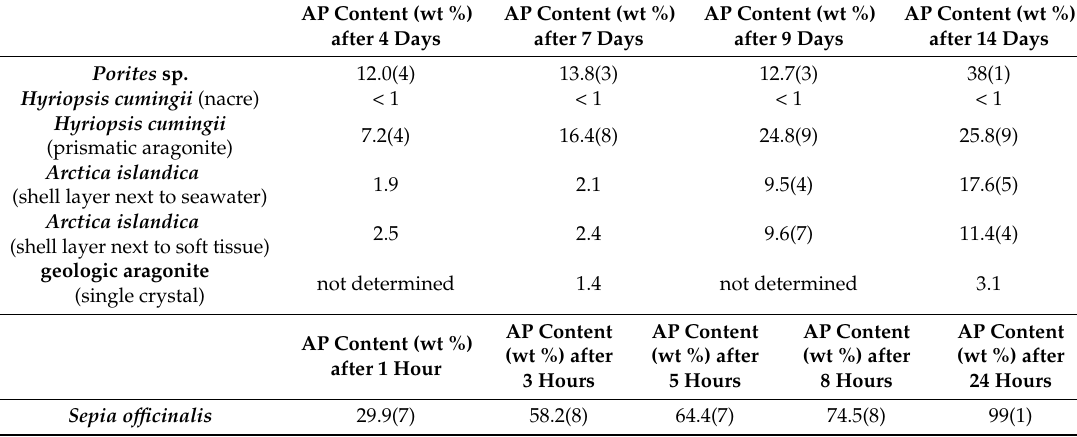
Table 1. Samples used for conversion experiments, experiment time periods and apatite contents obtained for specific conversion times. AP Content (wt %) AP Content (wt %) AP Content (wt %) AP Content (wt %) after 4 Days after 7 Days after 9 Days after 14 Days Porites